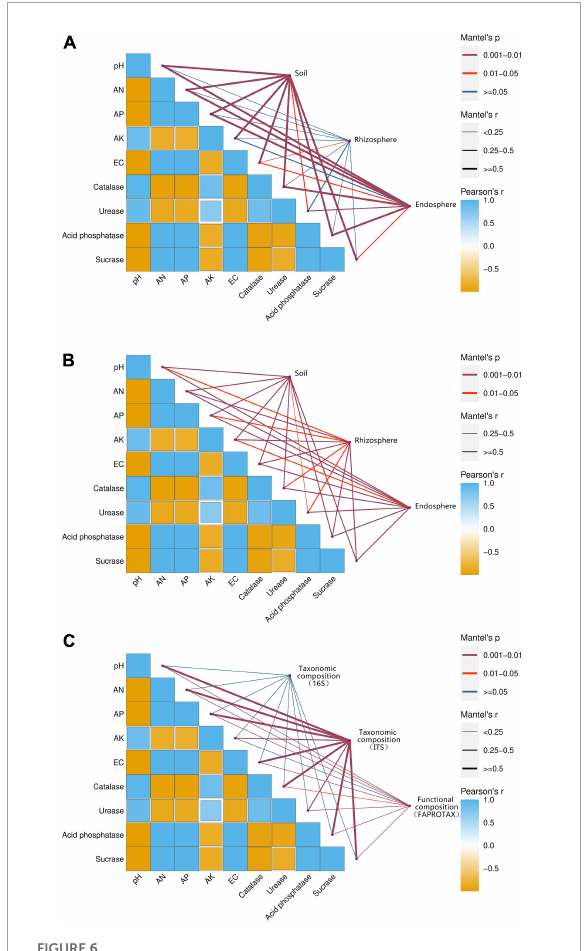
FIGURE6 Environmental drivers of compartments microbial community composition. Compartments (based on bulk soil, rhizosphere soil, and beetroot) microbial community composition of bacteria (A) and fungus (B) related to each environmental factor by partial Mantel tests. Taxonomic (based on 16S and ITS) and functional (based on FAPROTAX annotation) microbial community composition (C) related to each environmental factor by partial Mantel tests. The color gradient indicates Spearman’s correlation coefficients, with more positive values (dark blue) indicating stronger positive correlations, and more negative values (dark yellow) indicating stronger negative correlations. The edge widths correspond to Mantel’s r statistic for the